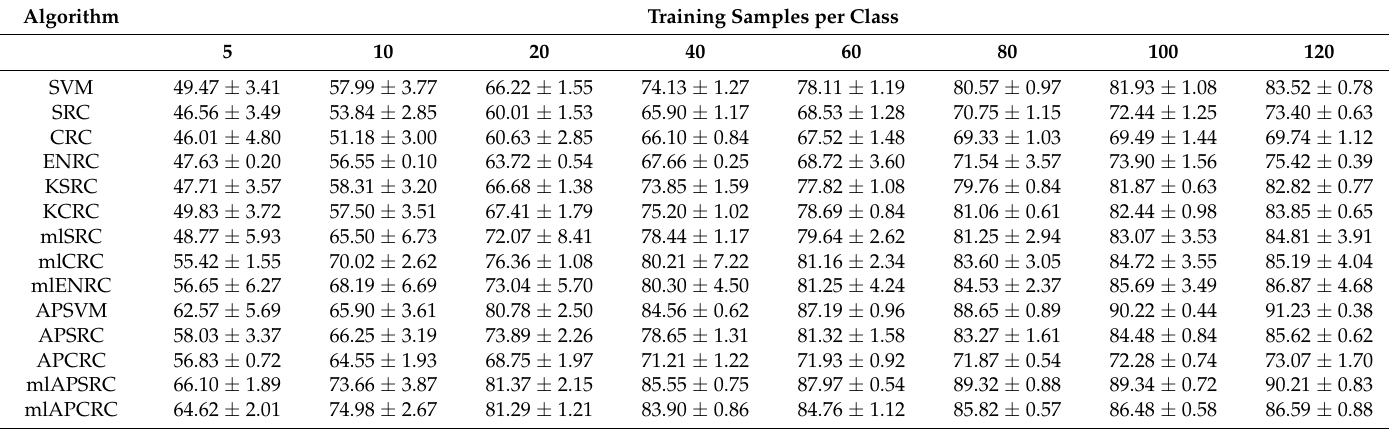
Table 3. Overall classification accuracy (%) and standard deviation as a function of the number of training samples per class for the Indian Pines image. KSRC, kernelized SRC; AP, attribute profile.